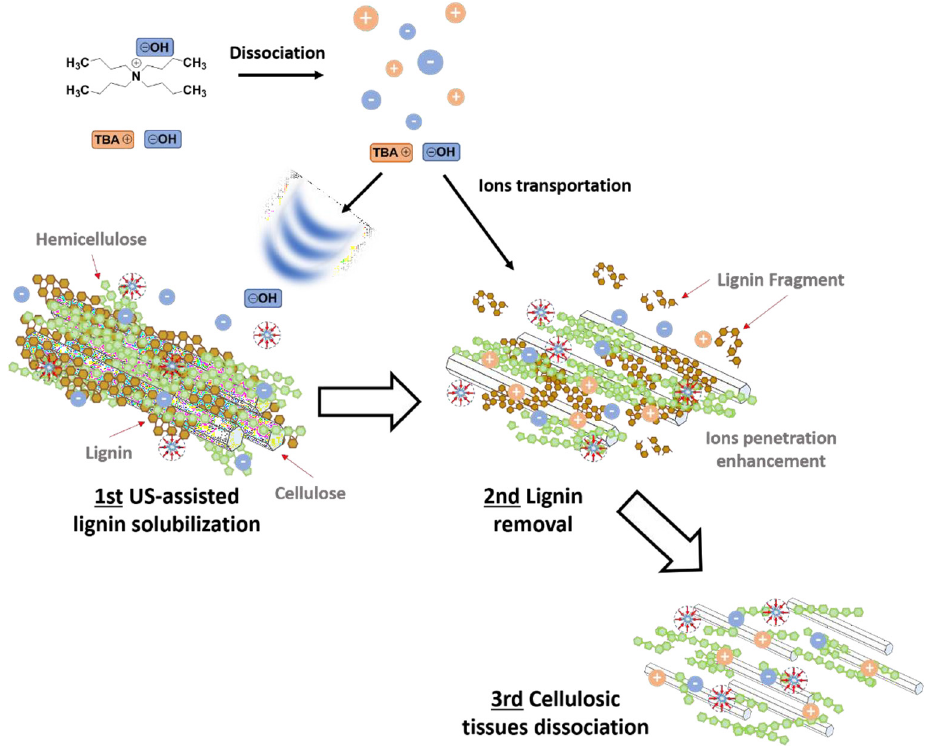
Figure 9. Mechanism of UAT with TBAH.